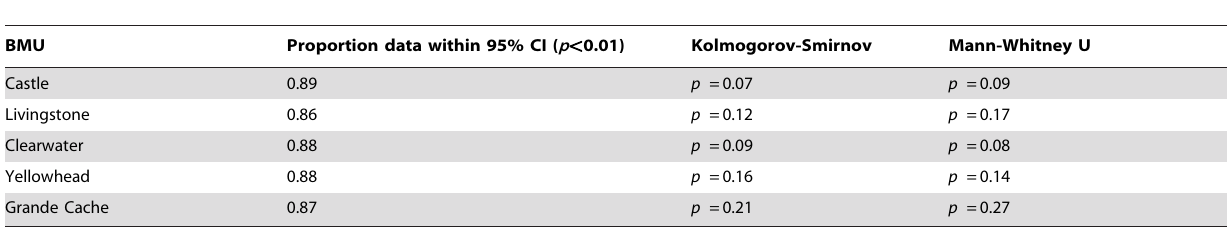
Table 2. HCC kernel density estimation validation results by bear management unit